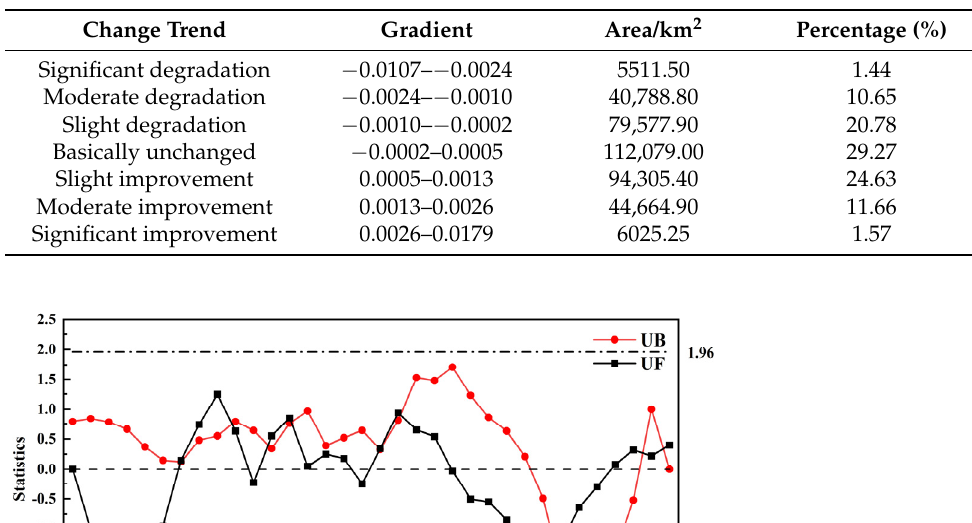
Figure 6. The results of the M-K test.